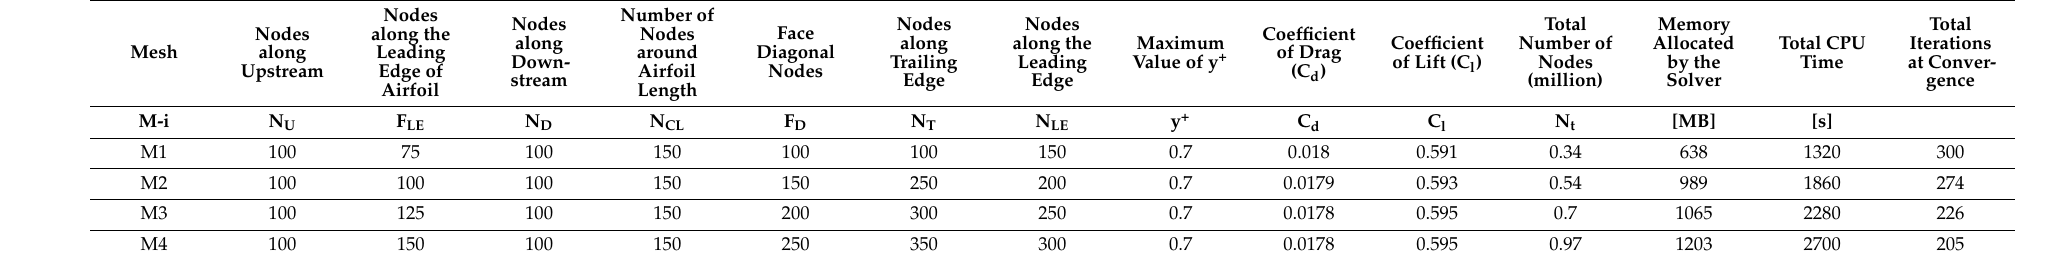
Table 2. Mesh distribution in the CFD domain for the grid independence